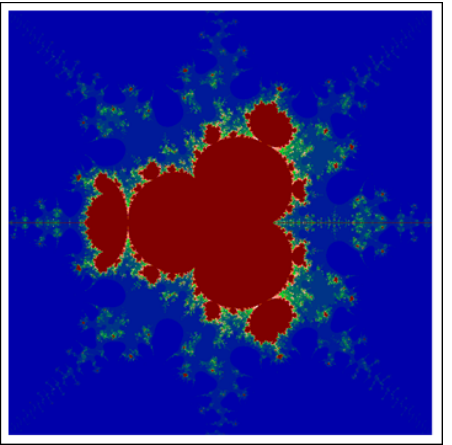
Figure 43. M-set via F-iteration sin ( z 4 ) + c with image visual time = 202